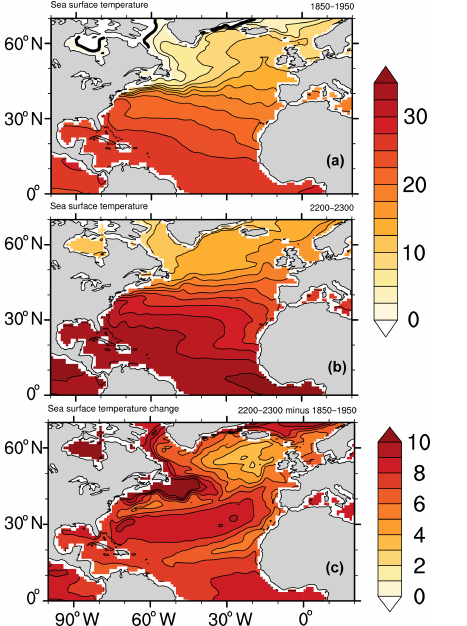
Figure 1. Sea surface temperature ( ◦ C) in (a) the historical sim- ulation (1850–1950), (b) RCP 8.5 (2200–2300) for the time mean and (c) difference between RCP 8.5 and the historical simulation. Contour interval is 2.5 ◦ in (a) and (b) and 1 ◦ C in (c)